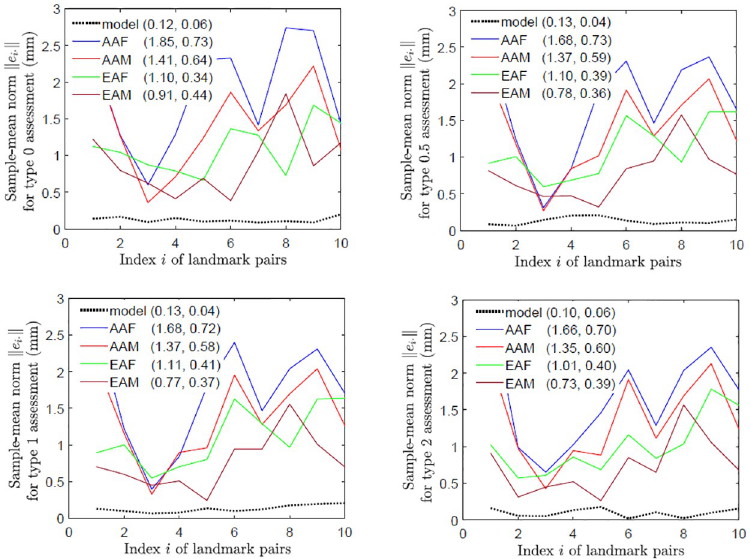
Fig 6. Non-fluctuating asymmetry of landmark pairs. The plots are for the perturbed symmetric skulls (model) and original skulls with respect to different assessment types (0, 0.5, 1 and 2) and in different categories (AAF, AAM, EAF and EAM), where in brackets are the means and standard deviations of the sample-mean norms of asymmetry indices.